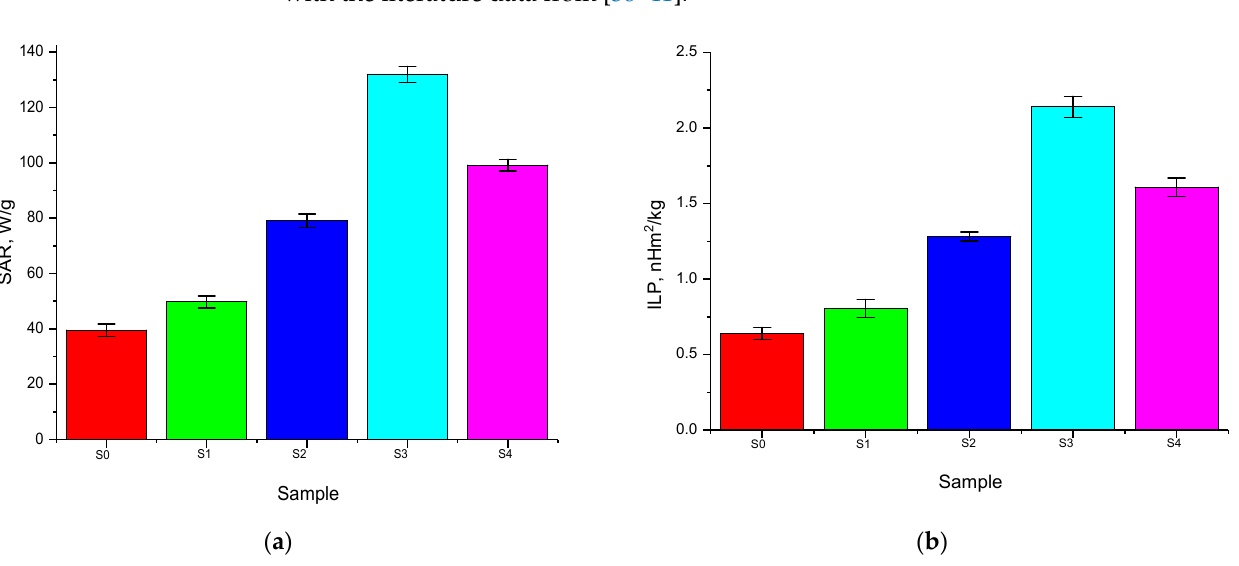
Figure 9. SAR ( a ) and ILP ( b ) diagrams for all studied nanoparticles.